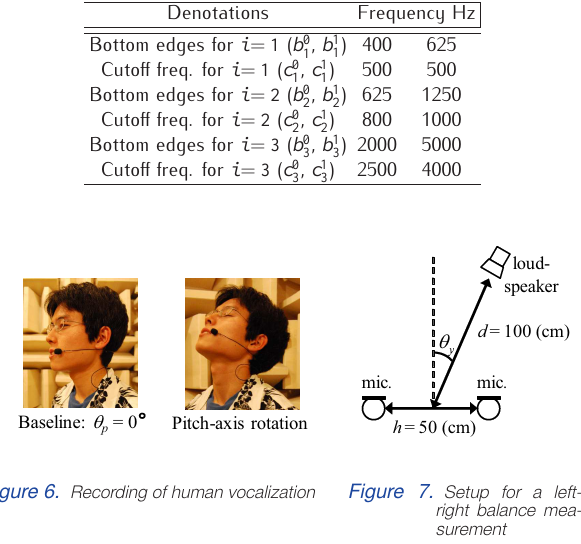
Figure 4showstheresultsofone-thirdoctavebandanalysisofthevoice 20 , 20 degrees. Negativepitchanglesindicate signalswhere, q p = 0 , − facing upward whereas positive ones indicate facing downward. We choose three frequency bandsmarkedwithblack dashedlines (500Hz, 800–1000 Hz, and 2500–4000 Hz) to manipulate the voice quality for the following reasons: